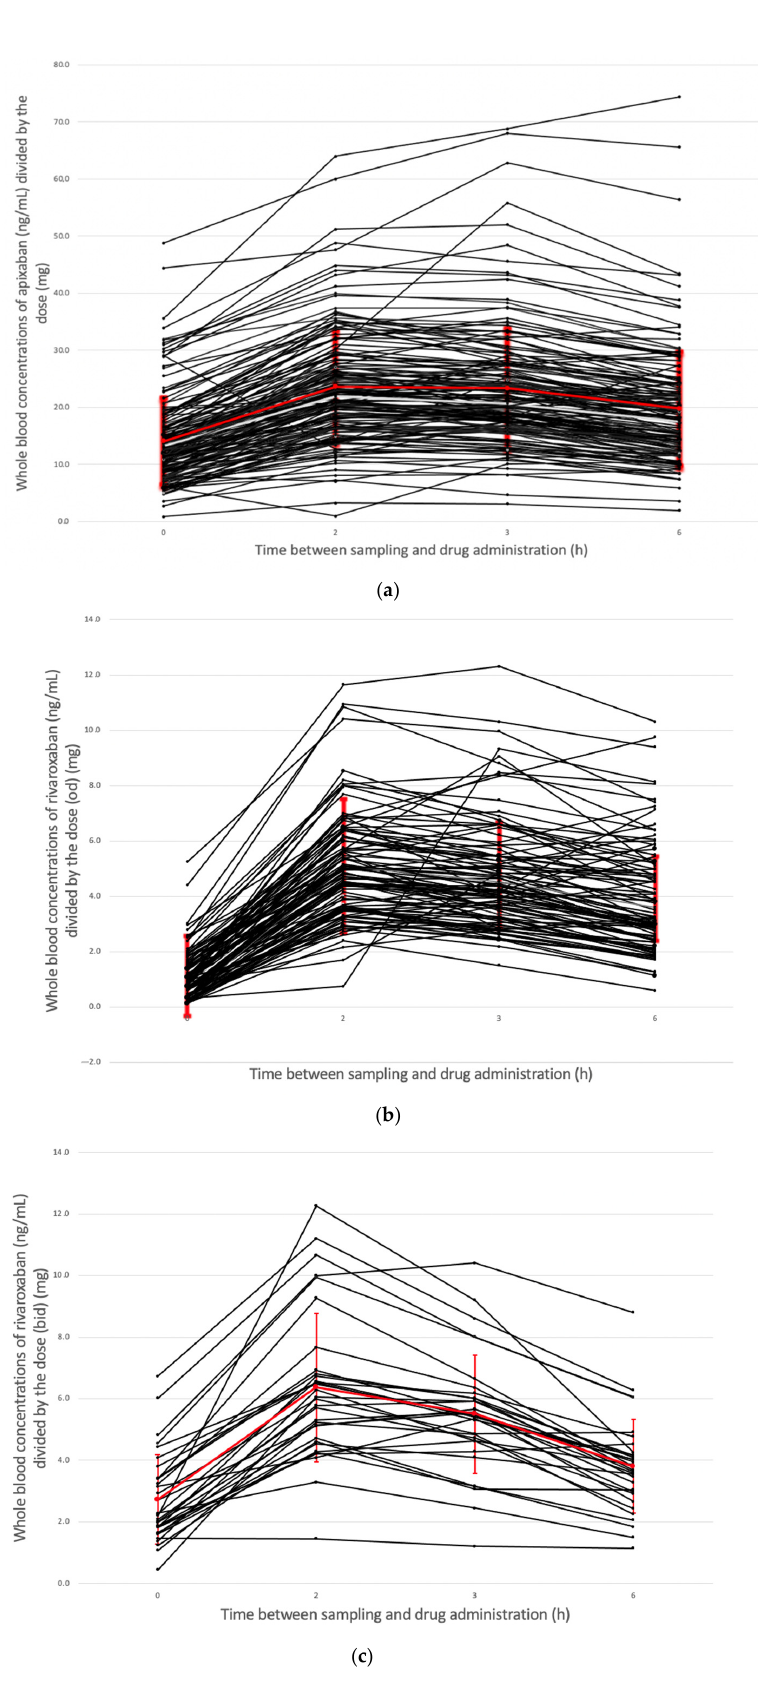
Figure 3. Blood concentrations normalized by the dosing regimen of ( a ) apixaban ( b ) rivaroxaban once daily and ( c ) and rivaroxaban twice daily. Each black line corresponds to an individual, and the mean ± SD is highlighted in red .